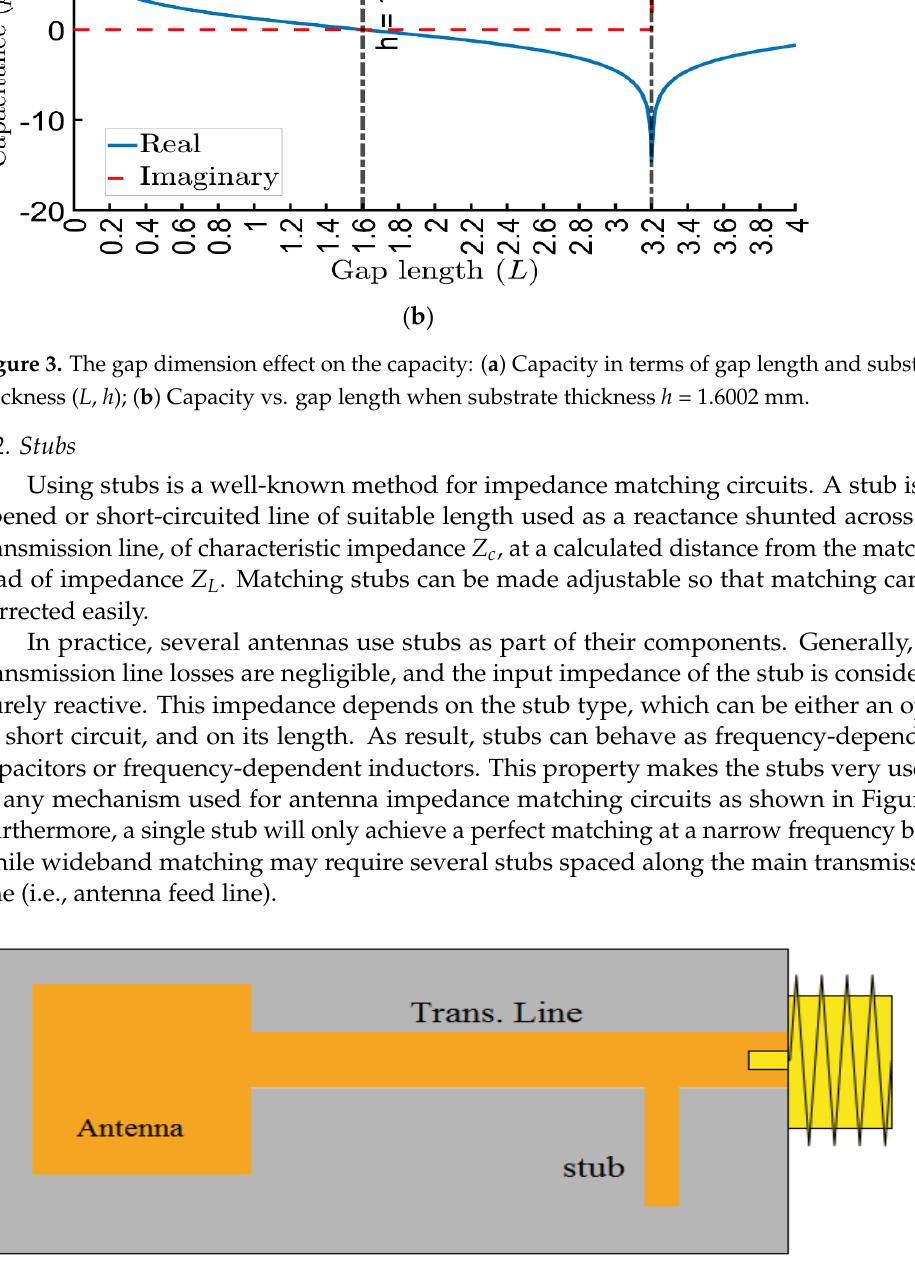
Figure 4. Stub placed just before an output connector to compensate for small mismatches due to the connector.